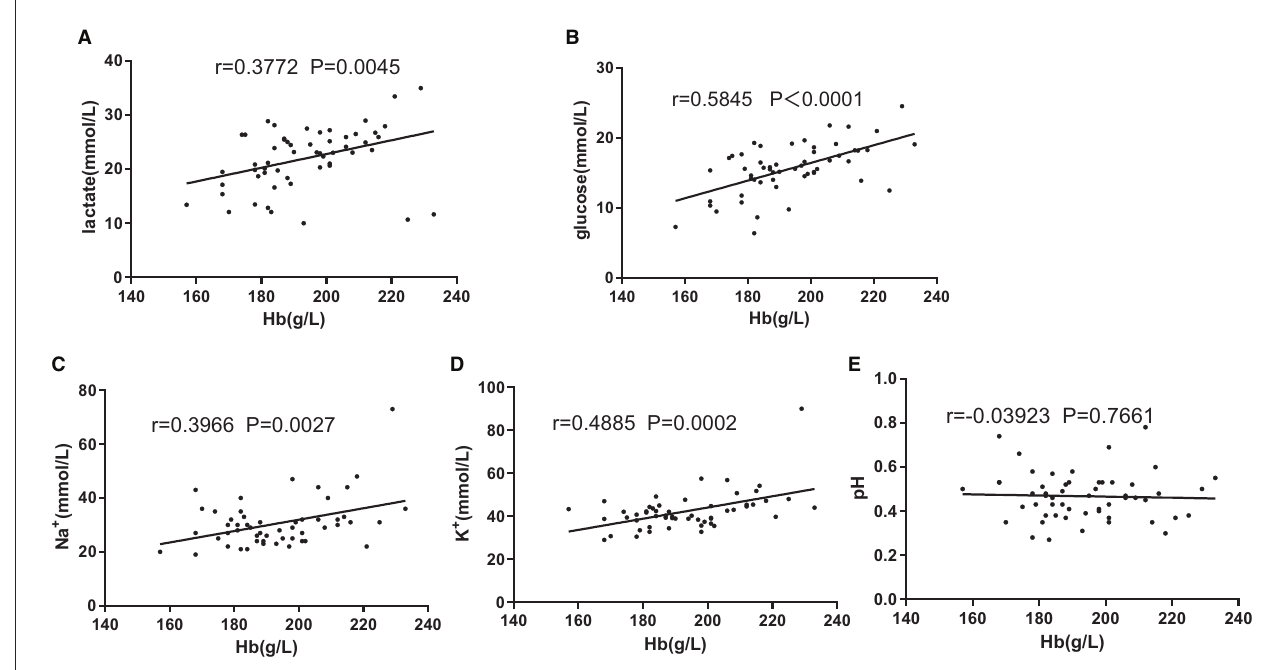
FIGURE4 Associations of change amount during the storage of lactate (A) and [Hb], glucose (B) and [Hb], Na + (C) and [Hb], K + (D) and [Hb], and pH and [Hb] (E) . Pearson’s partial correlation analysis was used.